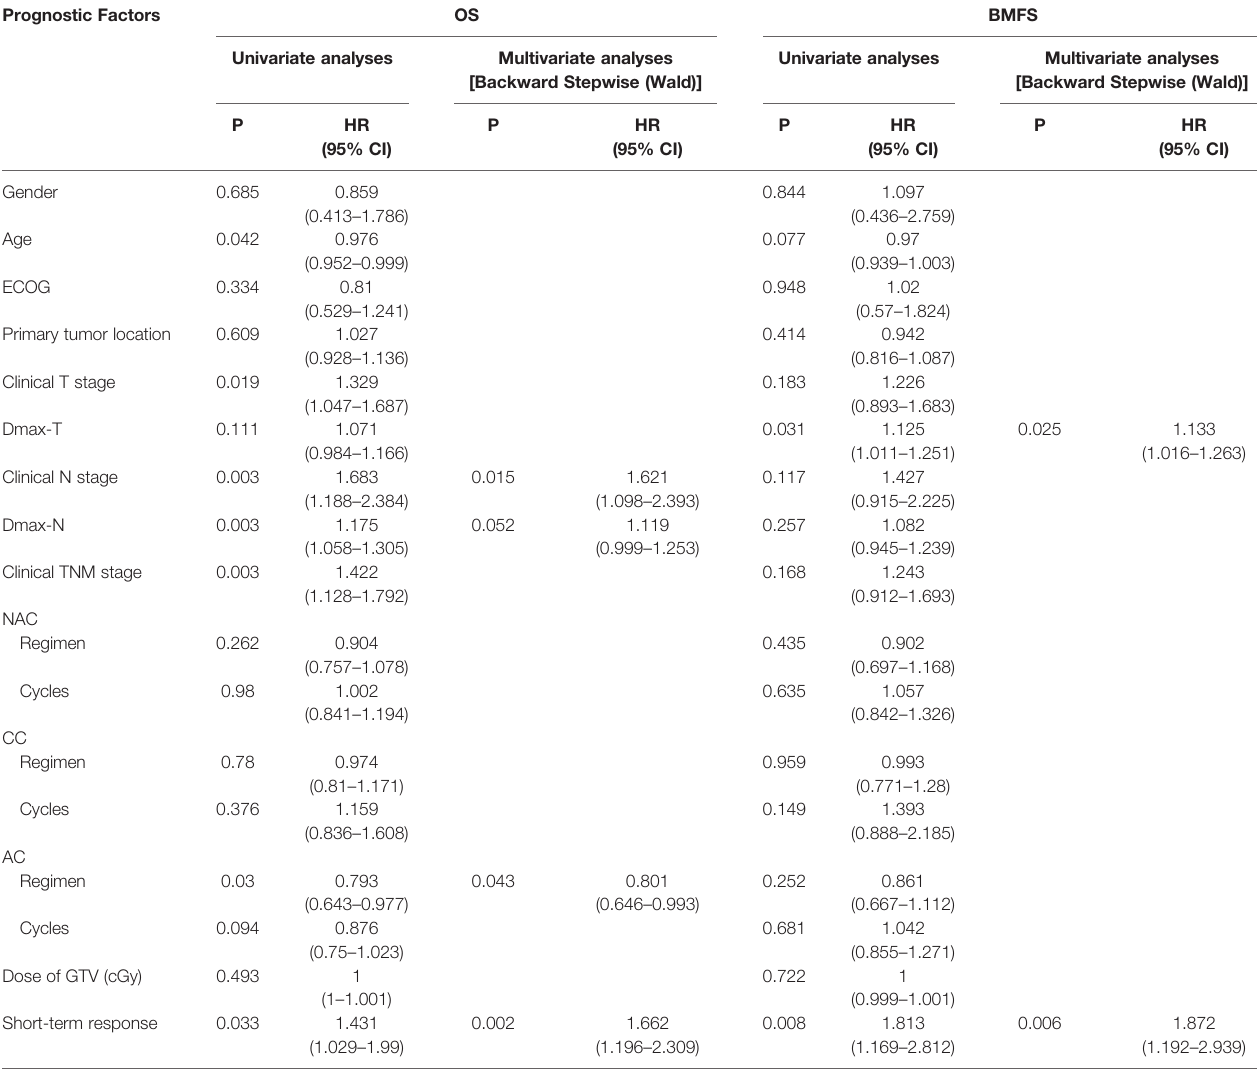
TABLE 3 | Prognostic factors by univariate and multivariate analyses for OS and BMFS. Prognostic